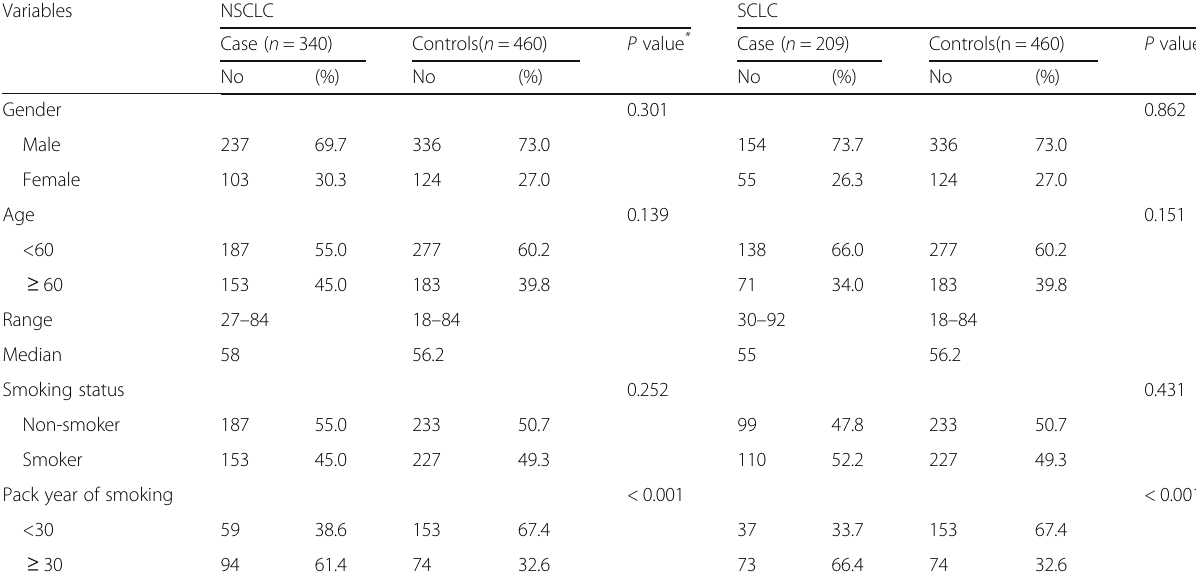
Table 1 Frequency distribution of select characteristics